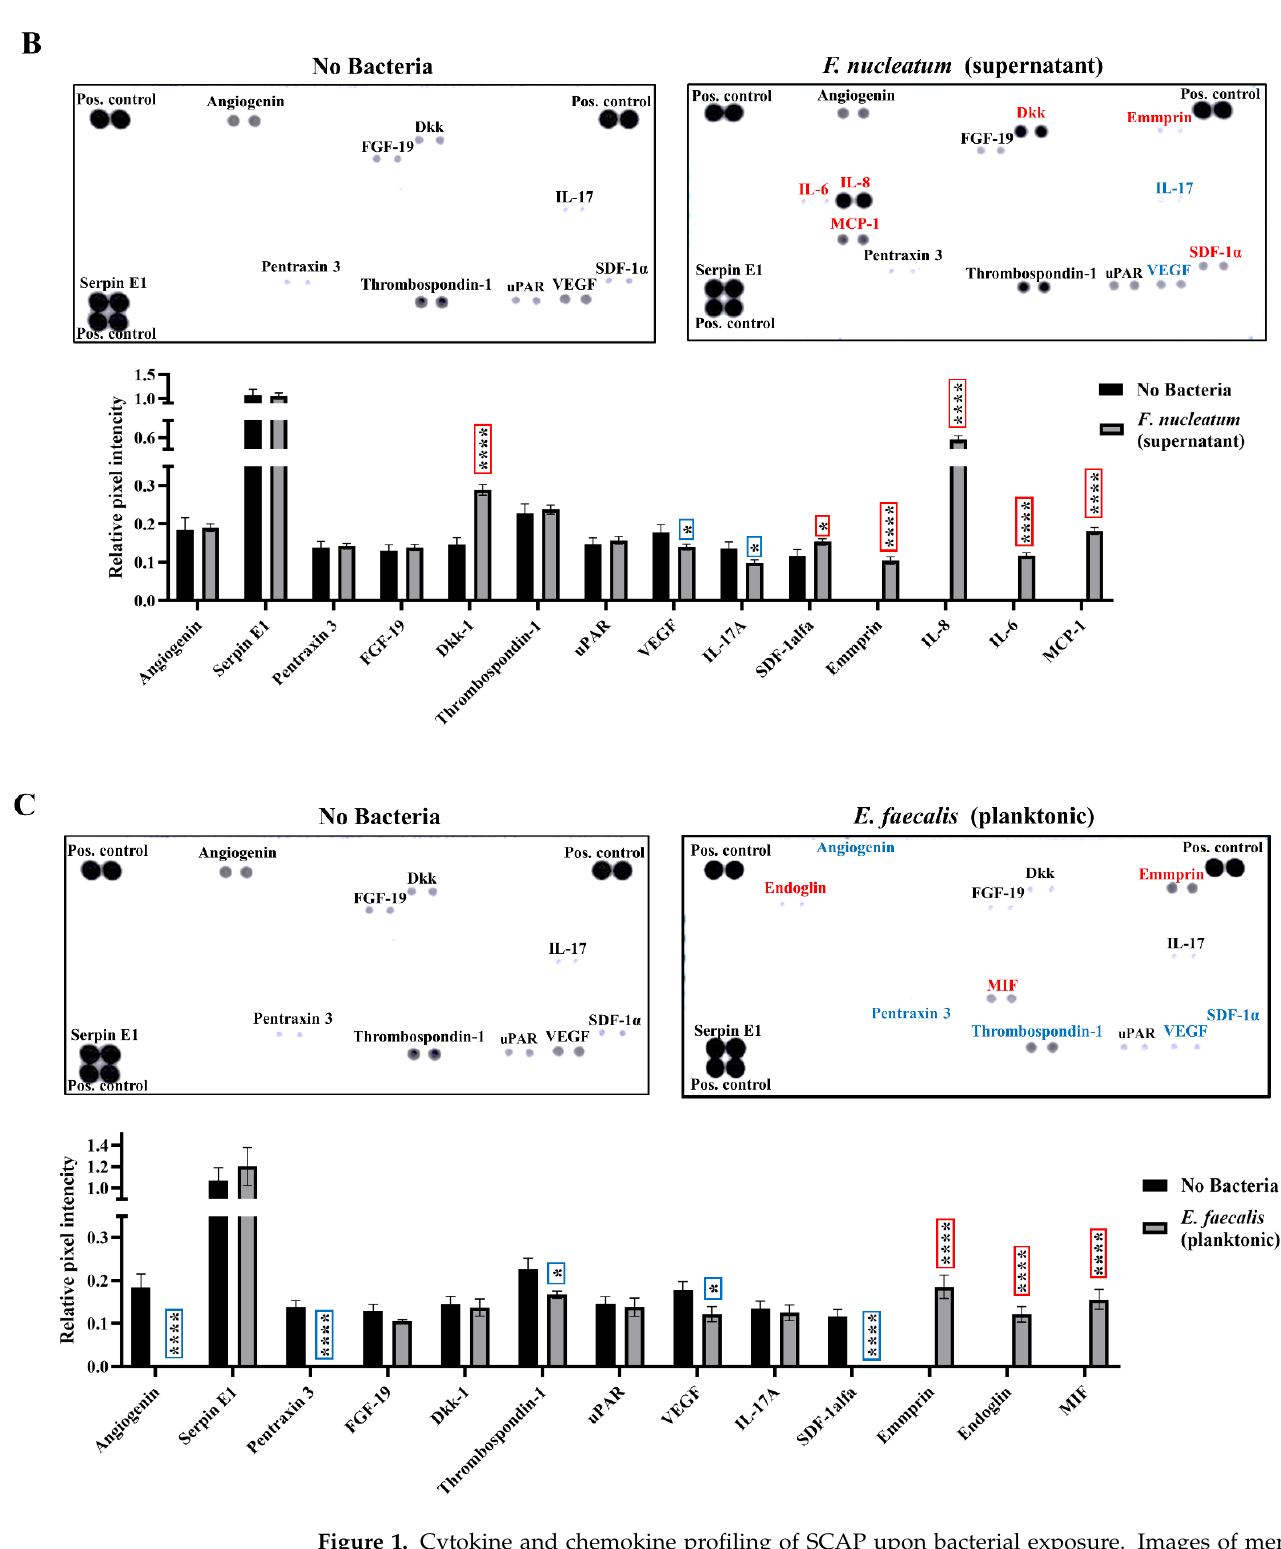
Figure 1. Cytokine and chemokine profiling of SCAP upon bacterial exposure. Images of mem- branes treated with SCAP infected by ( A ) F. nucleatum (planktonic), ( B ) F. nucleatum supernatants, or ( C ) viable E. faecalis (planktonic). Red text represents upregulation in comparison with the non- treated control. Blue represents downregulation of cytokines and chemokines. Difference between the relative intensity of immunospots of corresponding cytokine and chemokine in different SCAP culture variants is illustrated in staples: * ( p < 0.01), ** ( p < 0.001) or **** ( p < 0.00001). Data are presented as the mean ±